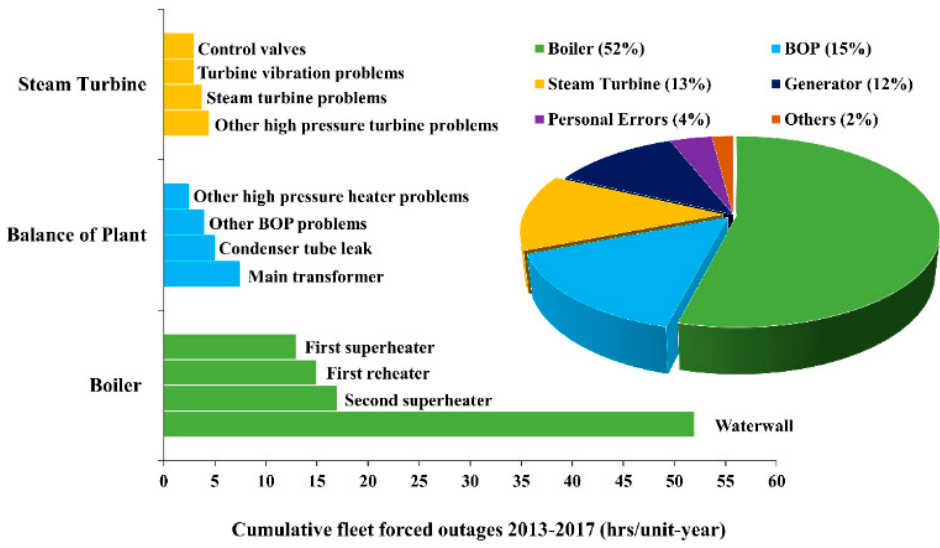
Figure 2. Survey of power plant faults representing the severity of the power plant faults and outage percentages.